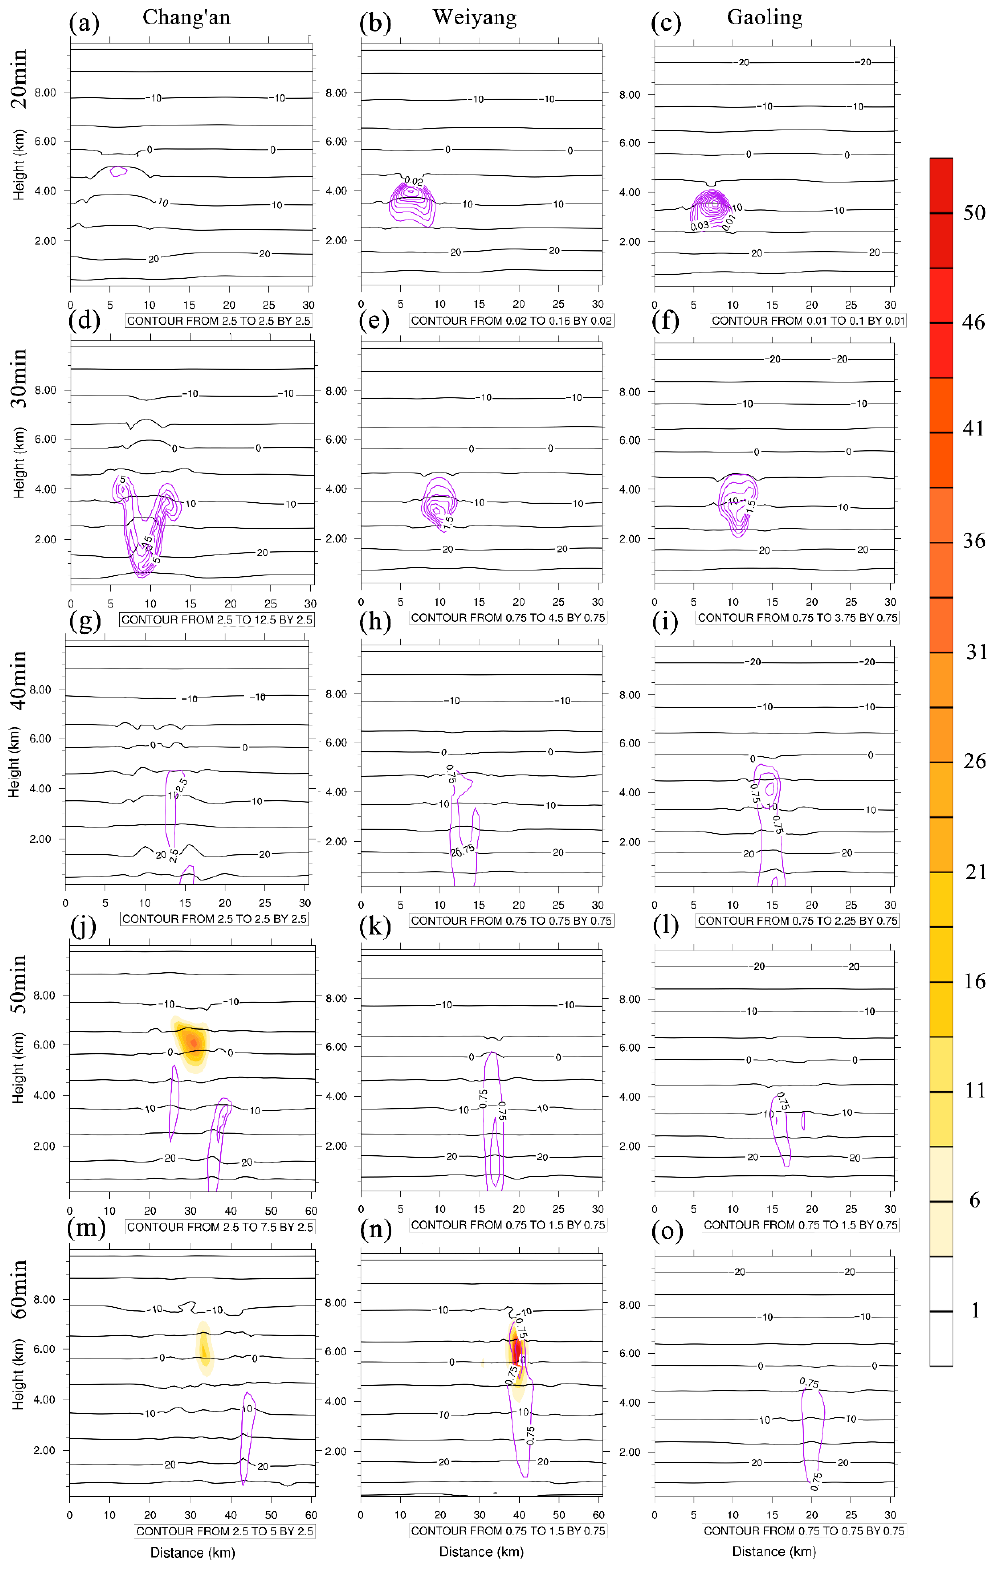
Figure 12. As shown in Figure 10, but for profiles of temperature (black line), rain (purple line), and hail (filled color). Units are g/kg (mg/kg for hail). (where ( a – c ) are 20 min, ( d – f ) are 30 min, ( g – i ) are 40 min, ( j – l ) are 50 min, ( m – o ) are 60 min. ( a , d , g , j , m ) are Chang’an District; ( b , e , h , k , n ) are Weiyang District; ( c , f , i , l , o ) are Gaoling District).